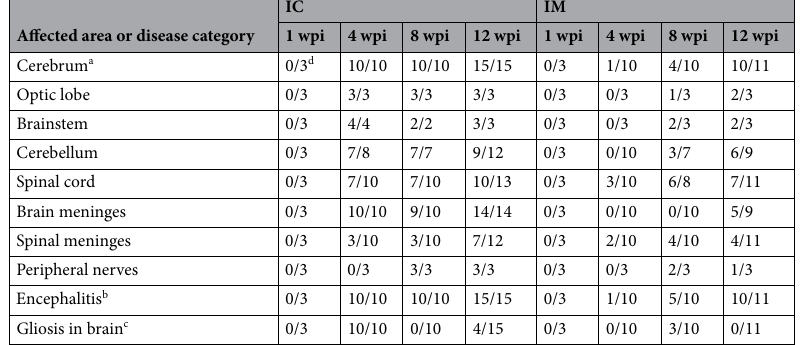
Table 1. Frequency of inflammation and gliosis in different areas of the nervous system of Muscovy ducks inoculated with ABBV-1 by the intracranial (IC) and intramuscular (IM) routes at 1, 4, 8, and 12 weeks post infection (wpi). a Indicates anatomical areas affected by inflammation, with the exception of “gliosis” category. b Encephalitis, as tallied in birds with inflammatory lesions in any brain section (cerebrum, optic lobe, brainstem, cerebellum). c Gliosis, as tallied in birds with proliferation/hypertrophy of glial cells or glial nodules in any brain section (cerebrum, optic lobe, brainstem, cerebellum). d Number of birds with disease in that anatomical location/number of birds tested at that time